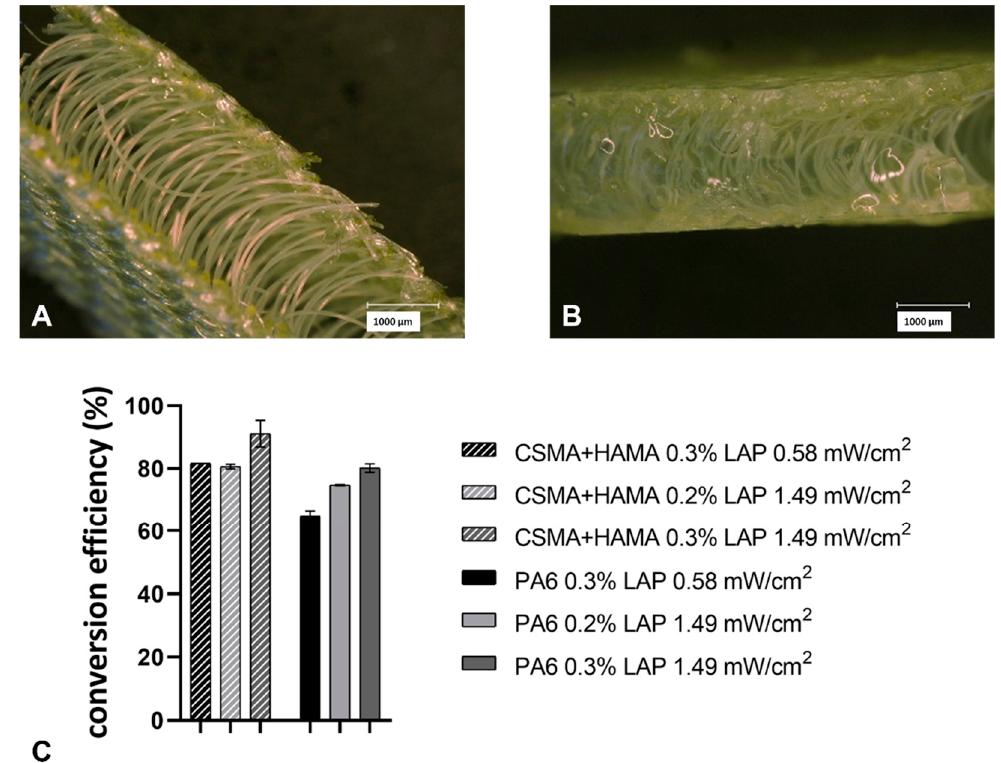
Figure 2. ( A ) Empty spacer fabric (PA6), scale bar 1000 µ m. ( B ) HydroSpacer construct with CSMA/HAMA hydrogel formed with PA6, scale bar 1000 µ m. ( C ) Methacrylate conversion efficiency of hydrogel samples with and without the addition of a PA6 spacer fabric (10 wt% polymers, CSMA to HAMA ratio 6.5), tested under different polymerization conditions and photo-initiator concentrations. Samples polymerized with a UV intensity of 0.58 mW/cm 2 were exposed from one side for 15 min, whereas samples exposed to 1.49 mW/cm 2 were bilateral polymerized for 7.5 min from each side. Samples were tested in duplicate, except for CSMA + HAMA 0.3% 0.58 mW/cm 2 ( n = 1). The data are presented as the mean ± SD. Table 1. Conditions tested to optimize the conversion efficiency of the methacrylate groups upon